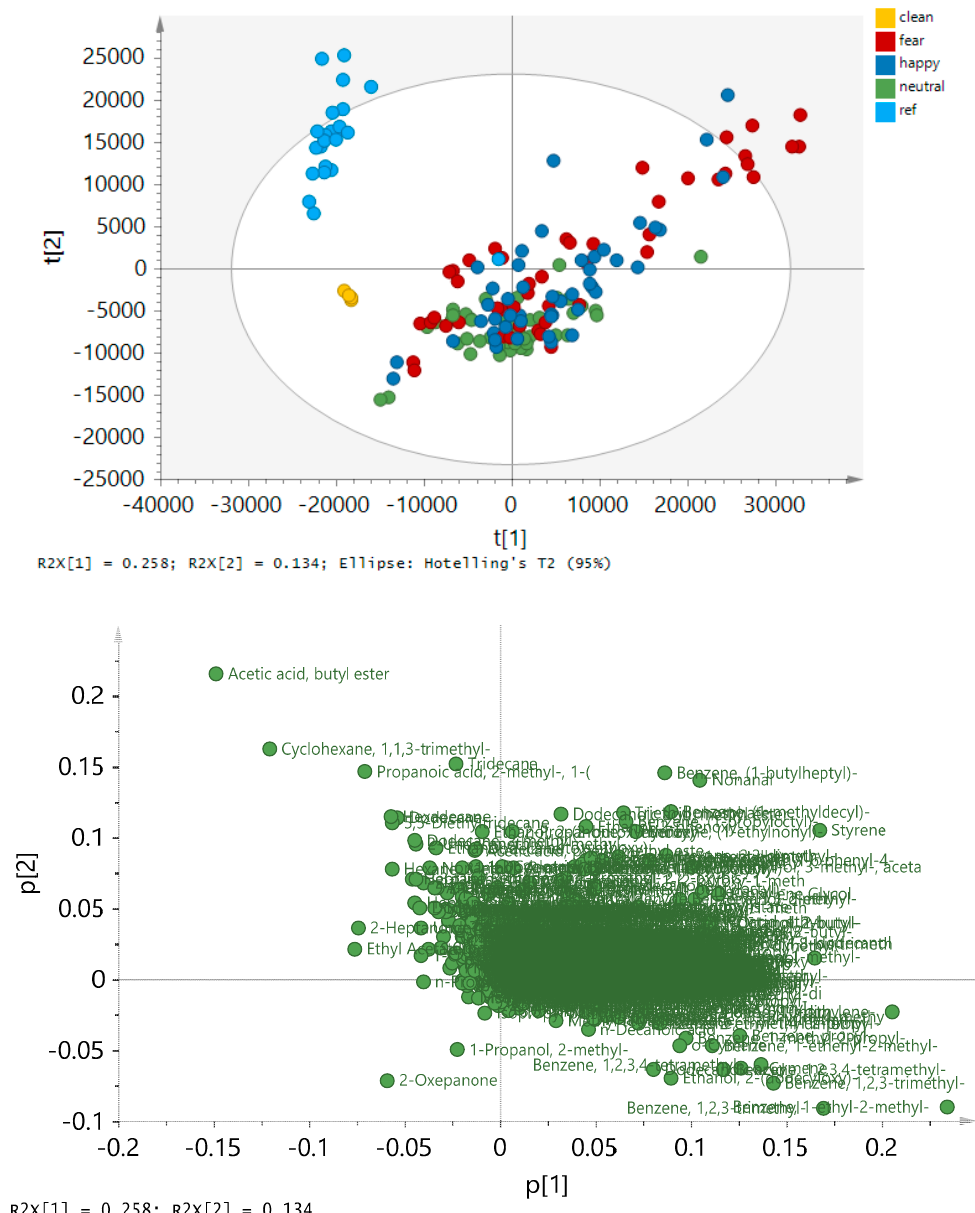
Figure A4. PCA performed on 3796 RT / MS peaks and 169 pads using Pareto scaling. The scores plot (upper panel) displays the variation of the pads classified as clean (from clean pads), reference (from pads deposited in the room), and the condition samples (Neutral, Happy, Fear from the subjects). The loading plot (lower panel) displays the variation of the analytes with tentative